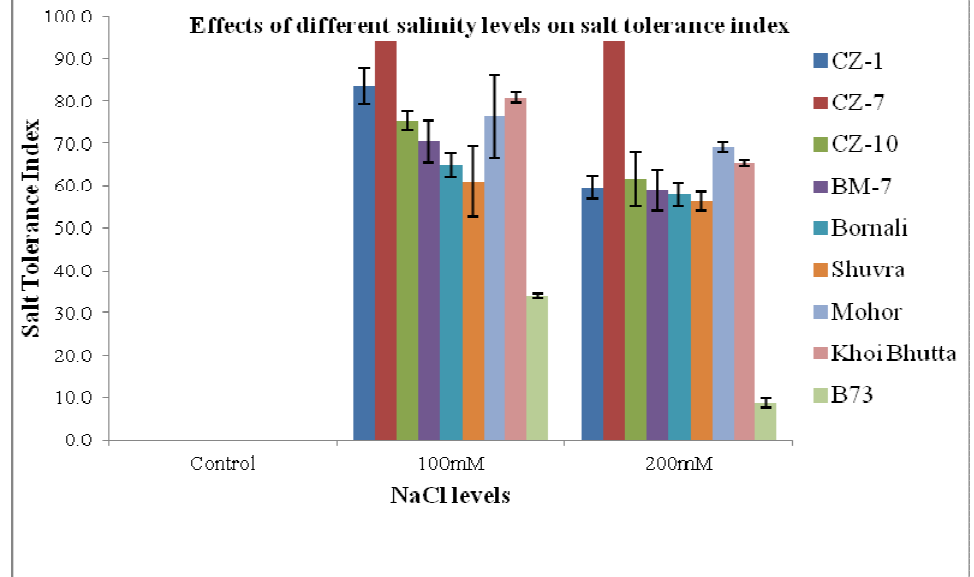
Fig. 7. Effects of different salinity levels on salt tolerance